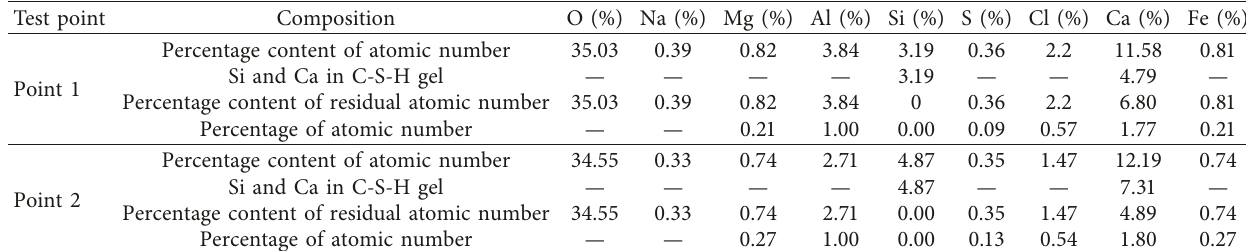
Table 10: Calculated chemical compositions: points 1 and